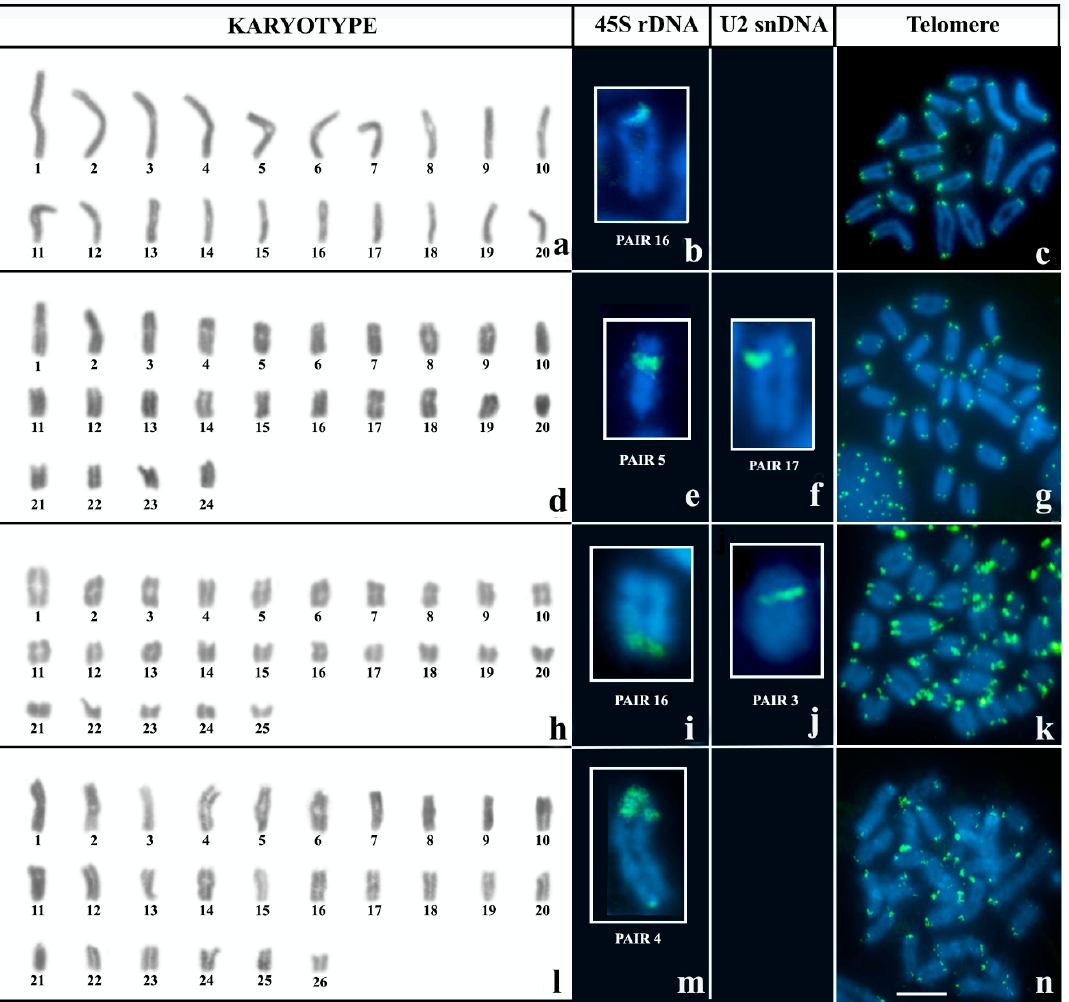
Figure 1. Meiotic karyotypes ( a , d , h , l ) and FISH with probes 45S rDNA ( b , e , i , m ), U2 snDNA ( f , j ) and TTAGG telomeric repeats ( c , g , k , n ) in different species of Brotheas . ( a – c ) B. silvestris , 2n = 40; ( d – g ) B. paraensis , 2n = 48; ( h – k ) B. amazonicus cytotype A, 2n = 50; ( l – n ) B. amazonicus cytotype B, 2n = 52. Barr = 10 μ m.